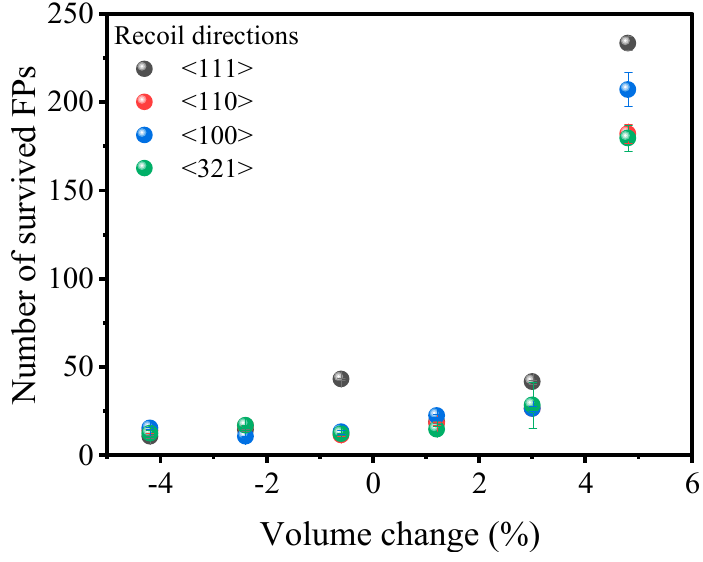
Figure 2. The number of Frenkel pairs that survive when different recoil directions of the 14 keV PKA are subjected to different levels of strain.